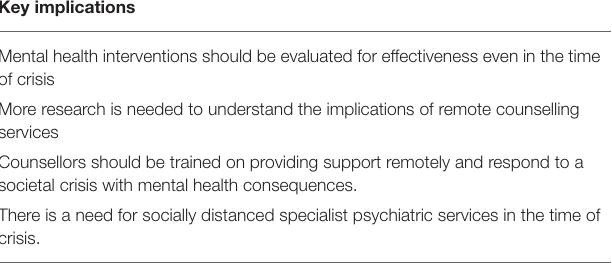
TABLE 4 | Key implications. Key